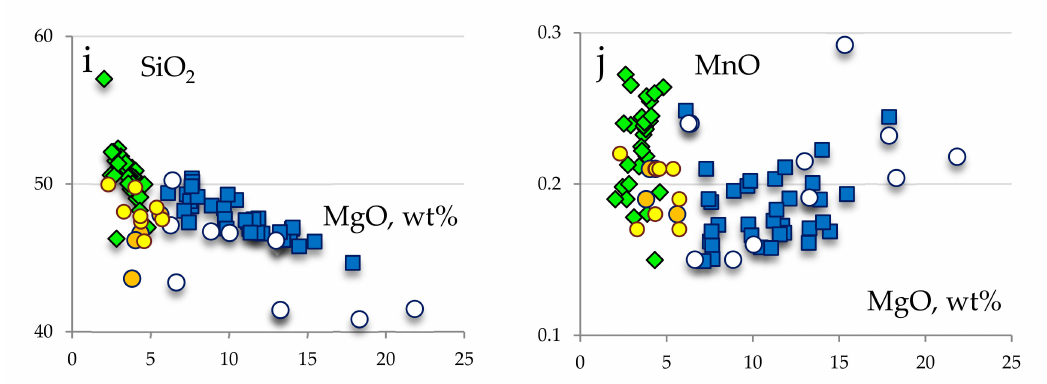
Figure 6. Oxides ( a ) TiO 2 , ( b ) Fe 2 O 3 , ( c ) Al 2 O 3 , ( d ) CaO, ( e ) K 2 O, ( f ) Na 2 O, ( g ) P 2 O 5 , ( h ) Na 2 O + K 2 O, ( i ) SiO 2 , ( j ) MnO vs MgO (as a di ff erentiation index) variation diagrams (wt %). Data for Norilsk and Ergalakh (Turumakit area) are from Table S1 and Table 1; Norilsk 1 intrusion-unpublished authors’ data, the Ergalakh data from the Kharaelakh trough-are from [16], Ergalakh (Ryabov)–data from the Ergalakh intrusion in the Norilsk trough